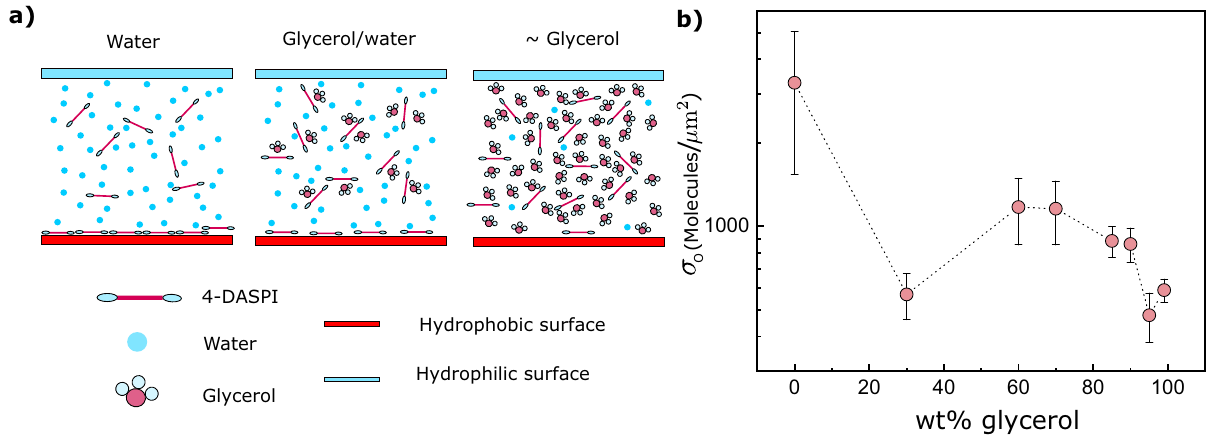
Figure 4. Adsorption of 4-daspi on hydrophobic glass decreases with glycerol concentration ( a ) Schematic representation of how reduction of energetically unfavourable contacts for molecules close to the glass- solution interface may drive the adsorption of 4-daspi to hydrophobic glass. ( b ) Adsorption of 4-daspi to the hydrophobic surface ( σ O ) as deduced from confocal intensity z -scans, corrected for artefacts as described in the text. Error bars 1 s.d. for data collected at z F = 5, 7, 10, 20, 30 µ m. The black dashed line is just to guide the